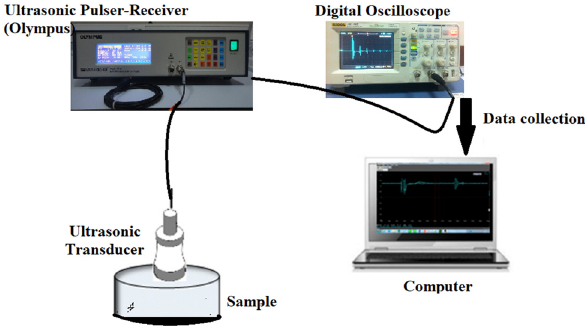
Figure 1: Schematic diagram of the experimental setup for ultrasonic properties of composite samples by the ultrasonic pulse - echo